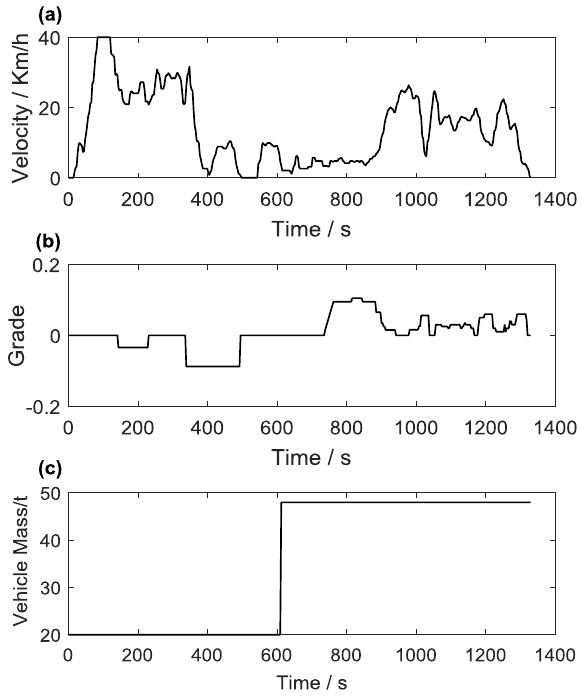
Figure 12. Driving cycle information: ( a ) velocity; ( b ) road grade; and ( c ) vehicle mass.